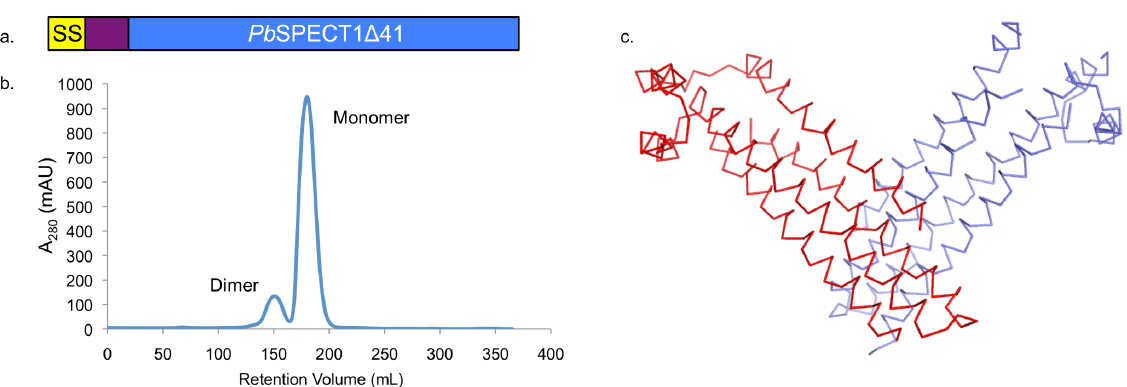
Figure 1. Monomeric and Dimeric Forms of Pb SPECT1 D 41. a . Schematic to scale of Pb SPECT1. Yellow denotes the putative signal sequence, purple the portion of the mature protein not included in Pb SPECT1 D 41, and blue Pb SPECT1 D 41. b . Size exclusion chromatogram of Pb SPECT1 D 41 showing